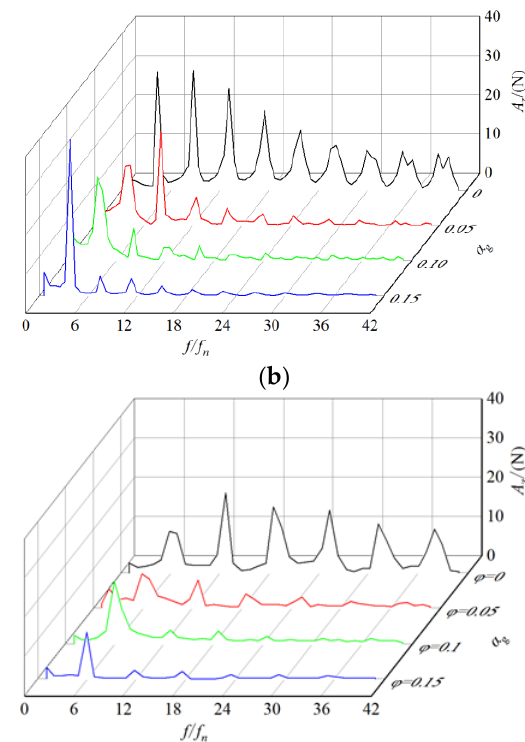
( d ) Figure 14. Time domain characteristic of axial force during the start-up process. ( a ) t = 1 s; ( b ) t = 2 s; ( c ) t = 3 s; ( d ) t = 4 s. The frequency domain diagram of axial force is obtained by the FFT for the time do- main diagram of axial force in Figure 14, as shown in Figure 15. At t = 1 s, the dominant frequency of axial force is 2 f n , and its amplitude under the gas – liquid two-phase condi- tions is more significant than that under the pure water conditions. At t = 2 s, the dominant frequency of axial force is 4 f n , and its amplitude is the largest at α g = 0.15. The frequency domain amplitude of axial force under pure water conditions attenuates slowly. The axial force still has a large frequency domain amplitude at the high-order frequency multipli-